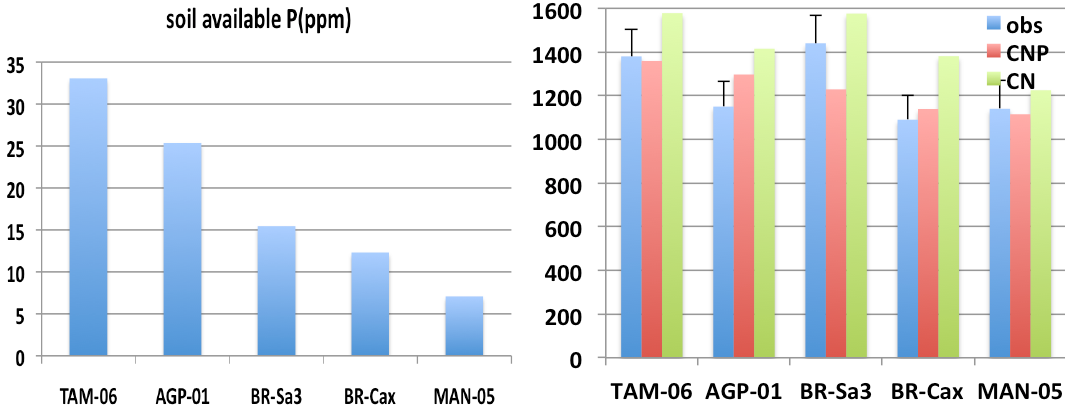
Fig. 4. (a) The amount of soil available P (mgkg − 1 ) for the five Amazonian sites (a) . Comparison of model-simulated NPP (gm − 2 a − 1 ) with the observations (with standard error bars) at the five Amazonian sites. Observations are from Aragão (2009).